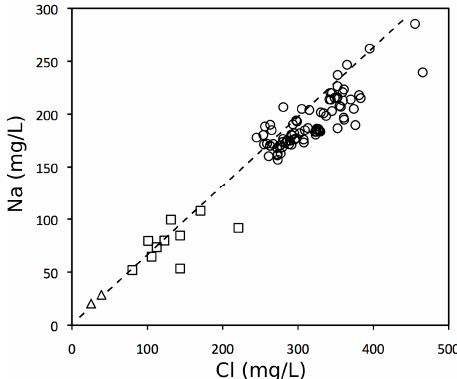
Figure 5. Na vs. Cl diagram. Open circles refer to lake water samples, squares refer to river waters and triangles to groundwater samples. Dashed line represents the theoretical dissolution ratio (Na/Cl = 0.65 by weight) of halite.